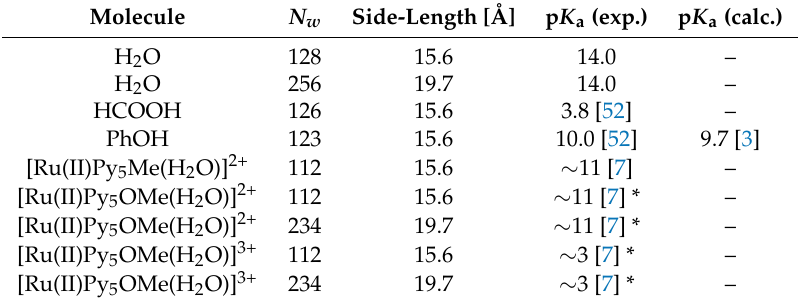
Table 1. Model systems used in this study. N w stands for the number of water molecules in the simulation cell. The calculated p K a value is only given if the simulations found in the literature were obtained employing the Bluemoon methodology. The Ru complex bears a pentapyridine (Py5) ligand that is composed of two bipyridyl fragments linked to a fifth pyridyl via an sp 3 carbon. The fourth fragment connected to the latter is either a methyl (Me) or methoxy (OMe) group resulting in Py5Me or Py5OMe (see [7,8,51] for more details). Experimental p K a values denoted with “*” were only available for the Py5Me ligand framework (see Supplementary Materials Figure S1 for a graphical representation of the